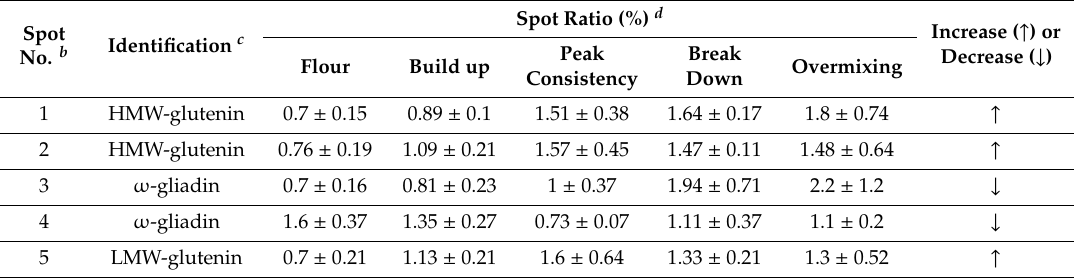
Table 3. Decreased and increased proteins in protein aggregates in LF a during